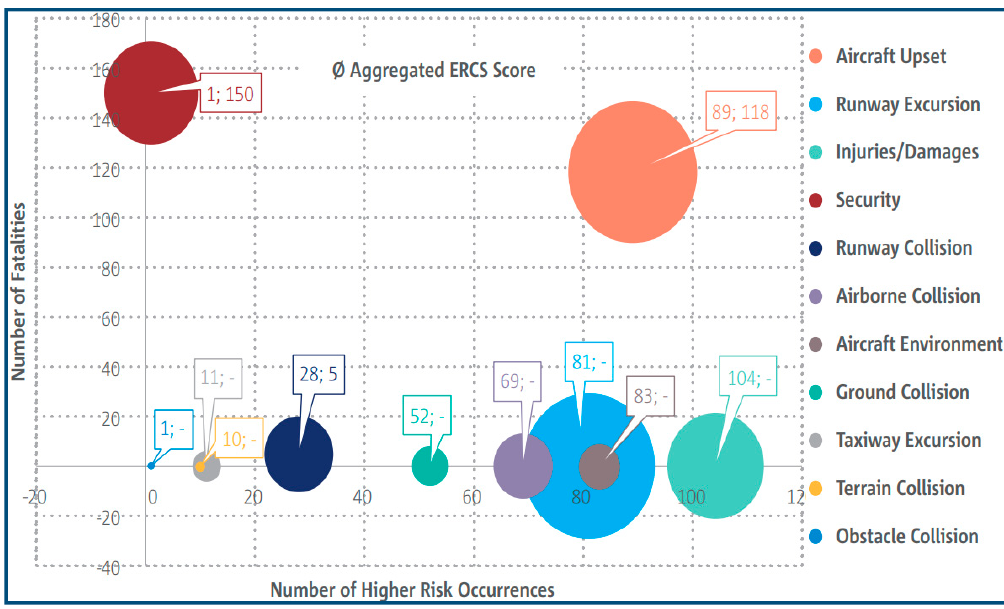
Figure 9. Key risk areas for CAT aeroplanes by fatalities 2013–2017, adapted from EASA (2018).